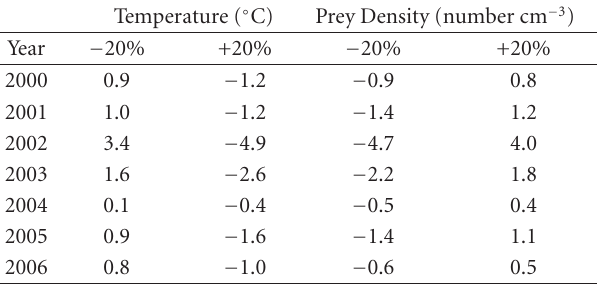
Table 3: Sensitivity of bioenergetic model estimates of juvenile sockeye salmon growth. For each analysis, one of the inputs (OSST ( ◦ C) or prey density (number/cm 3 )) was held constant while adjusting the other by ± 20%. A value of 1.0 means that a 20% increase in a value of SST or prey density from its nominal value caused a 20% increase in growth rate